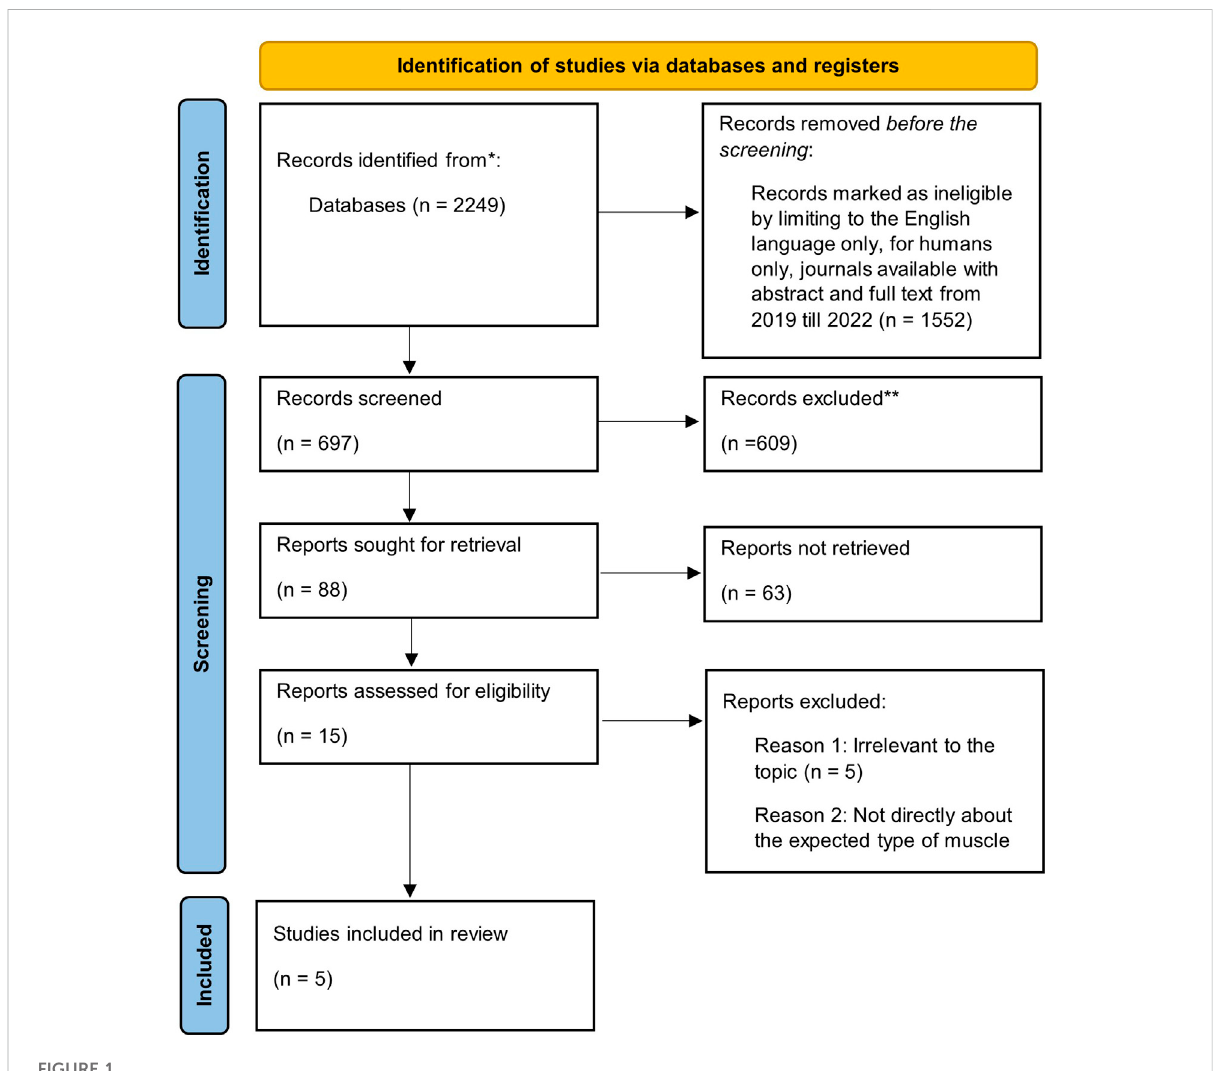
FIGURE 1 The PRISMA fl owchart for article